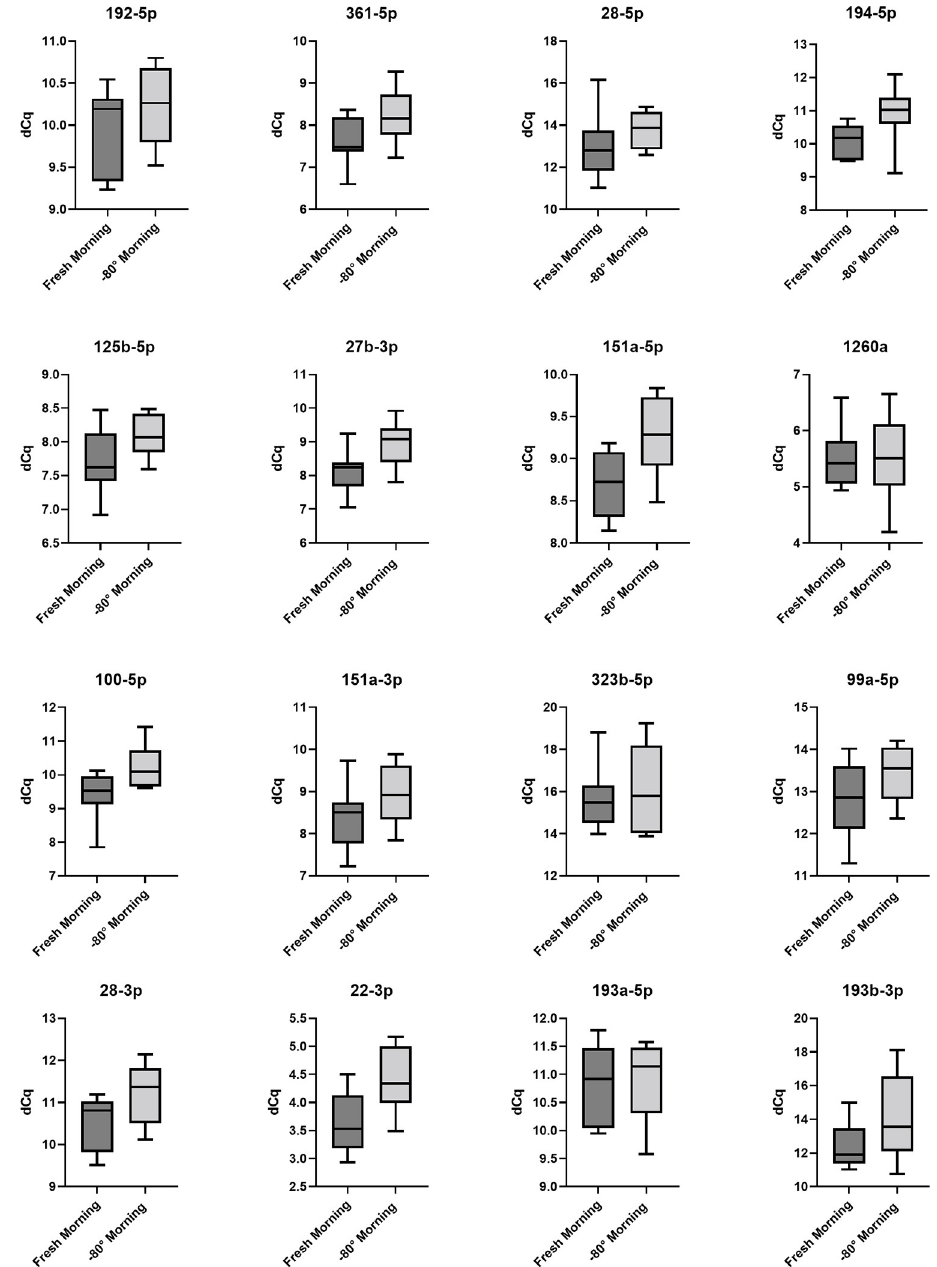
Fig 3. Fresh morning versus -80˚C morning. Box plots of dCq values of serum MiRNA samples taken at fasting condition compares the analysis within 24 hours (n = 8) and the analysis of samples (n = 8) after 14 days storage at -80˚C. The expression of miRNAs 194-5p, 27b-3p, 151a-5p, 100-5p, 22-3p was lower after being stored at -80˚ for 14 days. There were no significant differences (p < 0,01). Overall, there were small dCq mean differences in the panel of selected 16 miRNAs (Fig 5). Only the miRNA 193b-3p shows differences more than 1 dCq in all samples and the miRNA 100-5p shows difference above 1 dCq in the sample in the difference -80˚C morning/ -80˚C noon. Except for miRNA 193b-3p, these differences have no statistical significance.